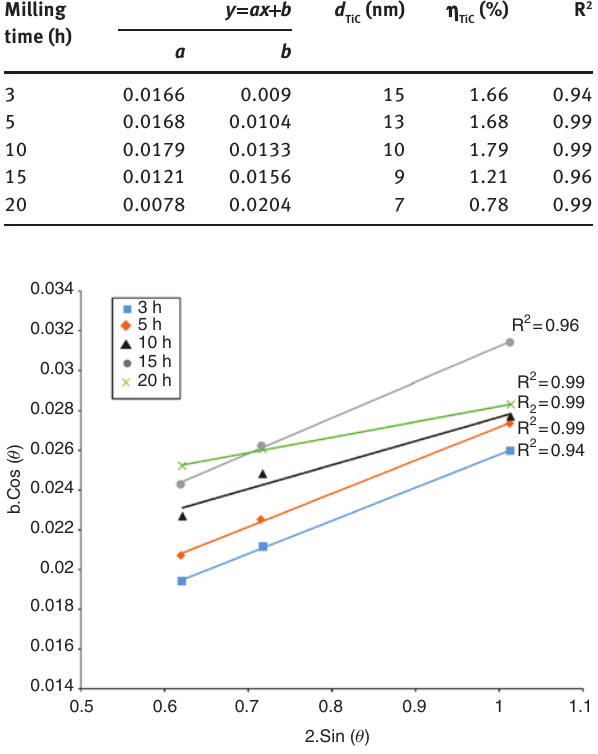
Figure 5: Williamson-Hall diagram of milled